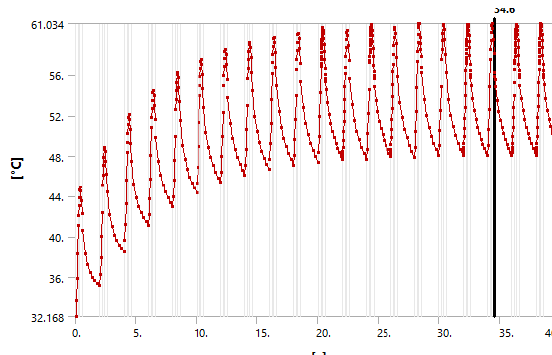
Fig. 14. Maximum inner wall temperature through forty seconds of operation